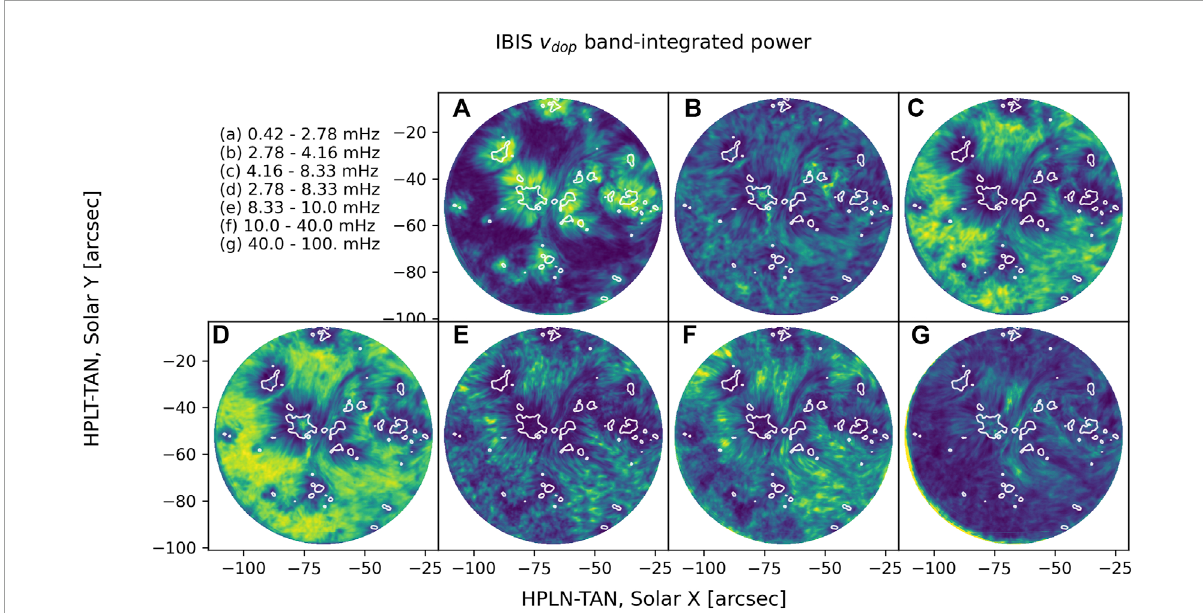
FIGURE 9 Spatial maps of the frequency-integrated power spectral density of the IBIS H α Doppler velocity over the seven frequency bands indicated in the upper left. These bands correspond to: (A) low frequencies; (B) 5 min oscillations; (C) 3 min oscillations; (D) combined p-modes; (E) near-cutoff; (F) mid frequencies; (G) high frequencies. The spatial coordinates correspond to the solar position at the beginning of the ALMA observations at 2017-03-21 15:42:13 UT. Note that the color scale is adjusted separately for each panel as the data span ≈ 40 dB . Higher power is bright yellow, lower power is dark blue. The white lines are the 50 G contours of unsigned LOS magnetic flux from HMI.